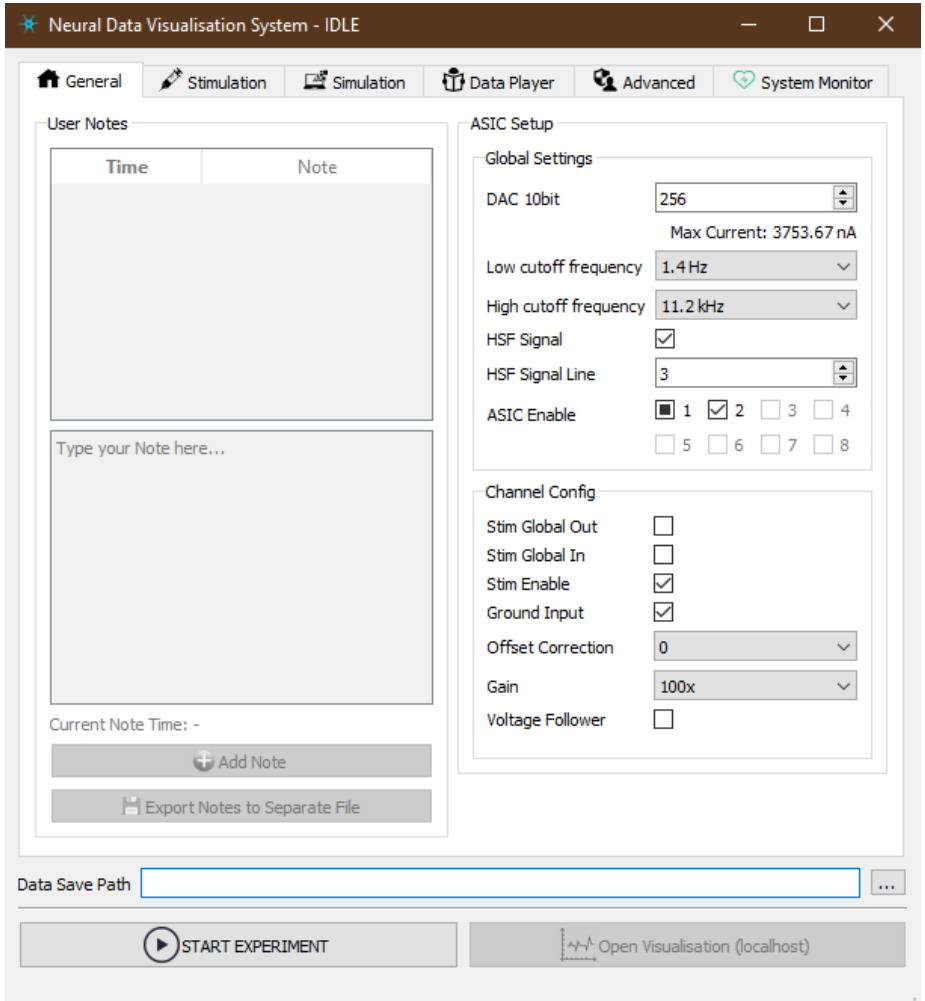
Figure 12. The main window of the Server Application allows setting up of experiment conditions including ASIC operation parameters and electric stimulation protocol. The interface is organised in tabs—each of them gives insight into the specific subsystem e.g., Data Player gives an opportunity to plan how to replay past experiment datasets while Simulation prints Finite State Machine (FSM) registers of enabled ASIC Simulators during data taking experiments with Neurostim-3 ASICs. Visualisation Client spawns two windows: one of them is the canvas where waveforms are being drawn, the second is the console with tunable parameters directly